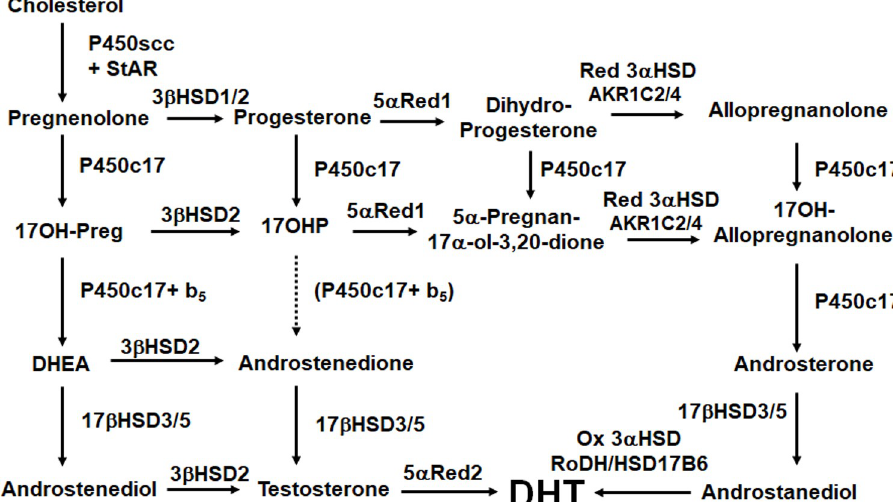
Fig 2. The “backdoor” pathway of androgen synthesis. Steroids in the left-hand column (the Δ 5 pathway) may be acted on by either 3 β HSD1 or 3 β HSD2 to yield the corresponding Δ 4 steroids. Following the production of Preg, the backdoor pathway typically features its conversion to 17OH-Preg, which is then converted to the key intermediary, 17OHP. In the brain (and elsewhere), progesterone may be converted to the neuroactive steroid, allopregnanolone. 17OHP is 5 α -reduced by 5 α Red1 (SRD5A1) to 5 α -pregnan-17 α -ol-3,20-dione, which is then 3 α -reduced by AKR1C2 or AKR1C4 to yield 17OH-allopregnanolone. P450c17 catalyzes its 17,20 lyase activity very efficiently when 17OH- allopregnanolone is the substrate, yielding androsterone, which O’Shaughnessy and colleageus show is the principal androgen in human male fetal circulation. Androsterone may then acted on by testicular 17 β HSD3 (or, to a minor degree, by adrenal 17 β HSD5 [AKR1C3]) to yield androstanediol, which may be 3 α -oxidized, probably by 17 β HSD6 (HSD17B6; also known as RoDH, to yield the most potent androgen, DHT. The work of O’Shaughnessy and colleagues shows that the human fetal testis instead uses progesterone produced by the placenta to generate the 17OHP that initiates the backdoor pathway. The identities of all of the enzymes catalyzing the reductive and oxidative 3 α HSD reactions have not been determined unambiguously. 17OHP, 17OH-progesterone; DHT, dihydrotestosterone; Preg, pregnenolone; RoDH, retinol dehydrogenase.